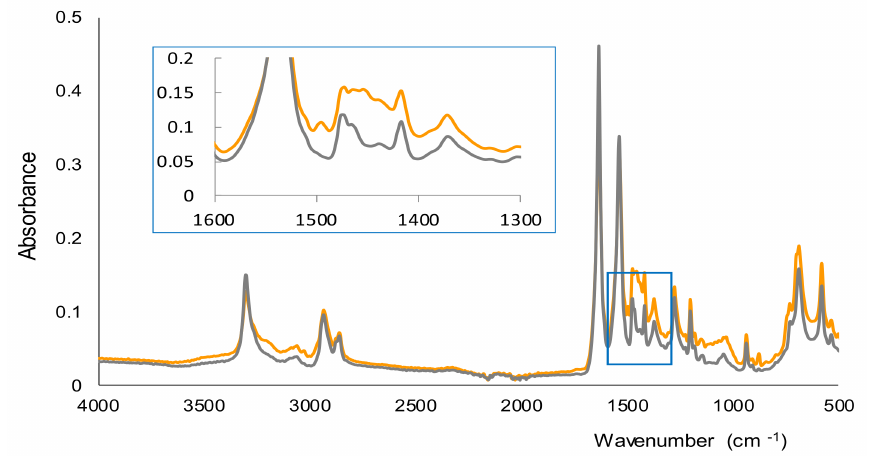
Figure 3. FTIR-ATR spectra of the membranes obtained for a blank (water) and a solution containing 500 ppm of AMP.